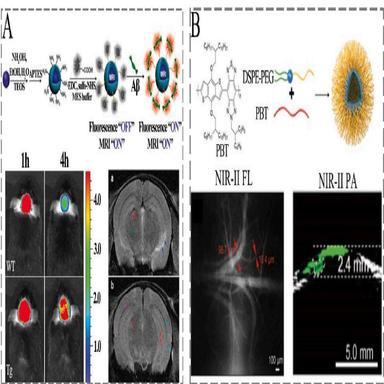
(A) NIR fluorescence images and T2-weighted MR images of an APP/PS1 transgenic mice from ref.. Copyright 2018 WILEY-VCH. (B) NIR-II fluorescence and photoacoustic imaging of cerebral vasculatures in mouse from ref.)]. Copyright 2019 WILEY-VCH.